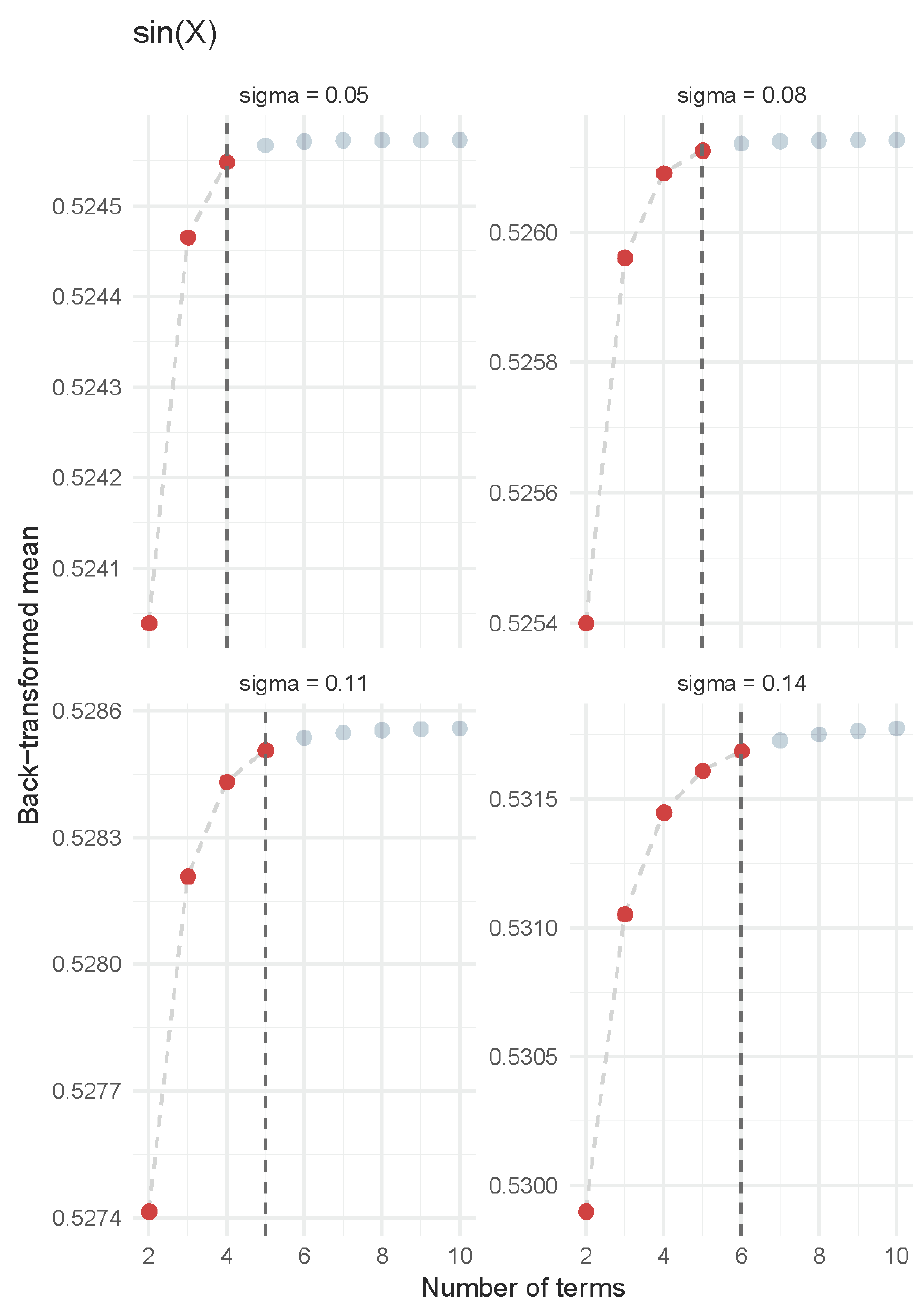
Figure 1. Convergence of sine transformation according to the number of terms in Taylor series expansion. The vertical dotted line identifies the number of terms for which two consecutive differences between Taylor series estimates are less than the preset value of the order of 10 − 5 .